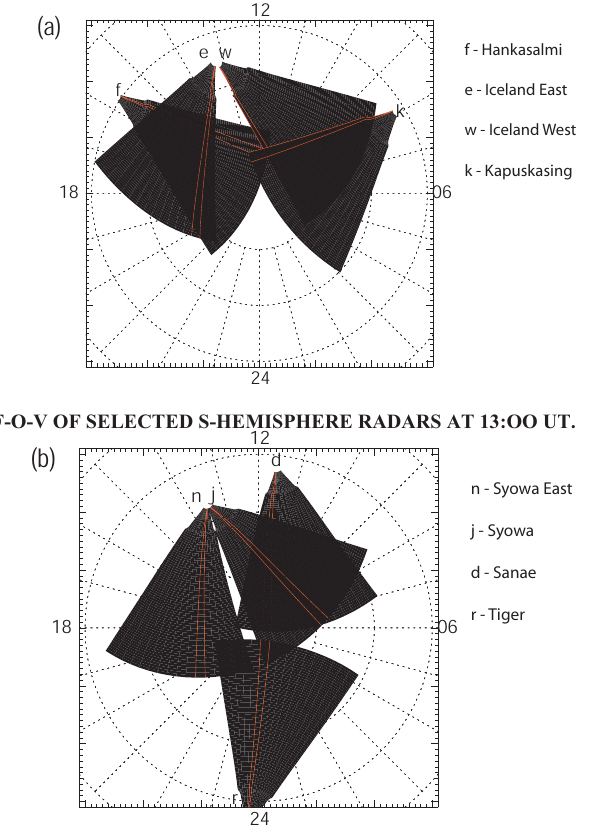
Fig. 5. The f-o-vs of the selected Northern (Fig. 5a) and Southern (Fig. 5b) SuperDARN radars are shown at 13:00 UT. The plots are in a MLAT/MLT co-ordinate system with 12:00 MLT being located at the top of the plots.